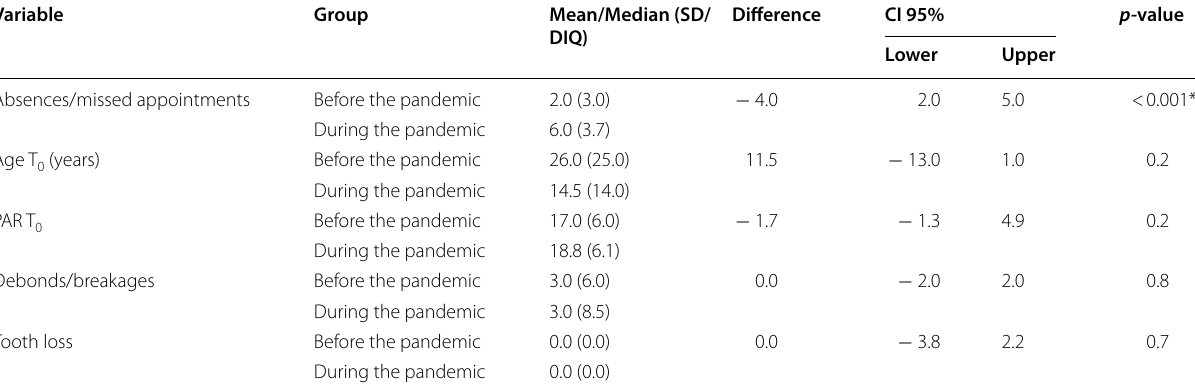
CI 95% confidence interval, SD standard deviation, DIQ interquartile deviation *Statistical significance p <